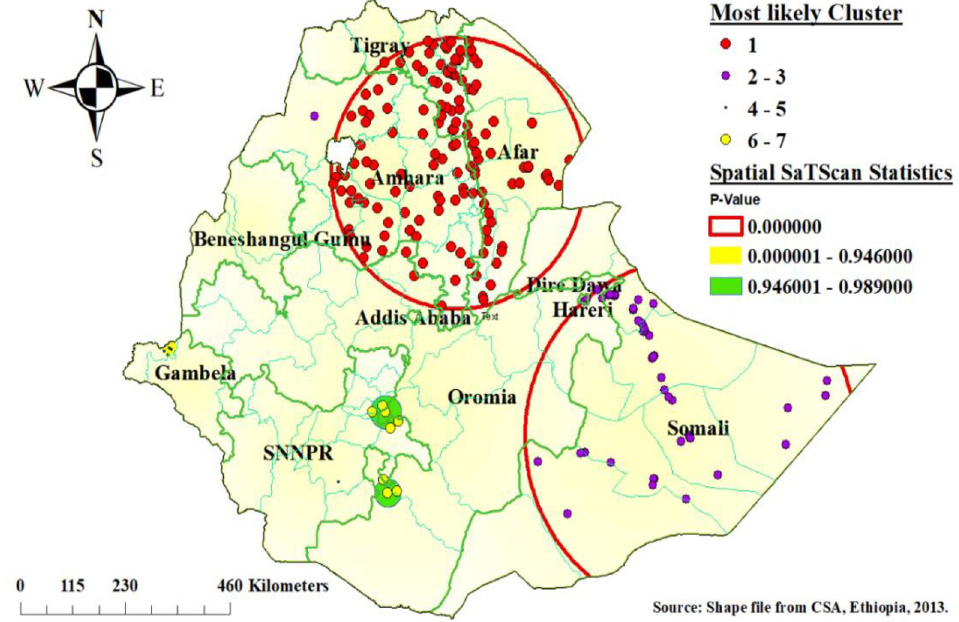
Fig 3. Most likely (primary) and secondary cluster for poor consumption of foods rich in vitamin A among children aged 6–23 months, Ethiopia.